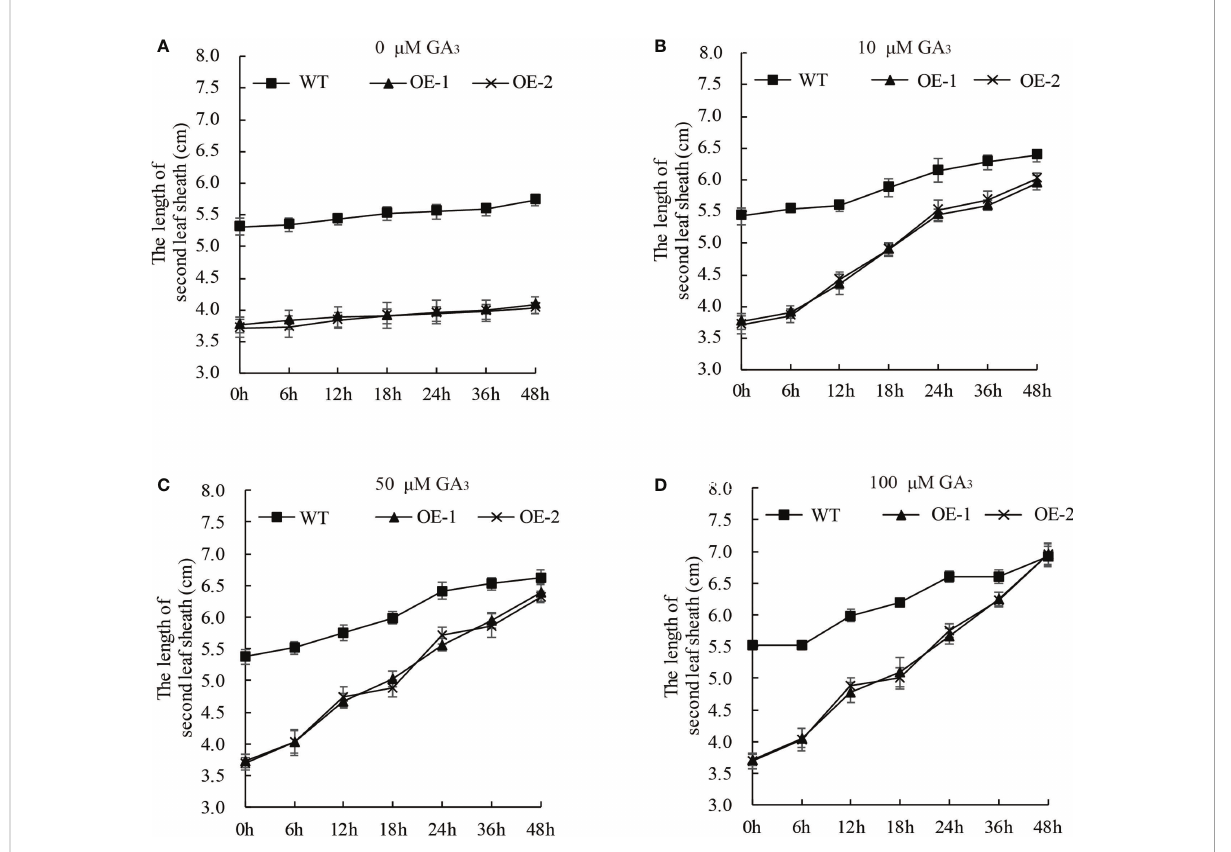
FIGURE 4 The dwarf phenotype of the OE plants can be rescued by GA 3 . Ten-day-old OE and WT seedlings were treated with 0 (A) , 10 (B) , 50 (C) , and 100 (D) m M GA 3 . At least 10 rice seedlings from each individual line were measured. Data are presented as the average of 10 samples per genotype ( ±